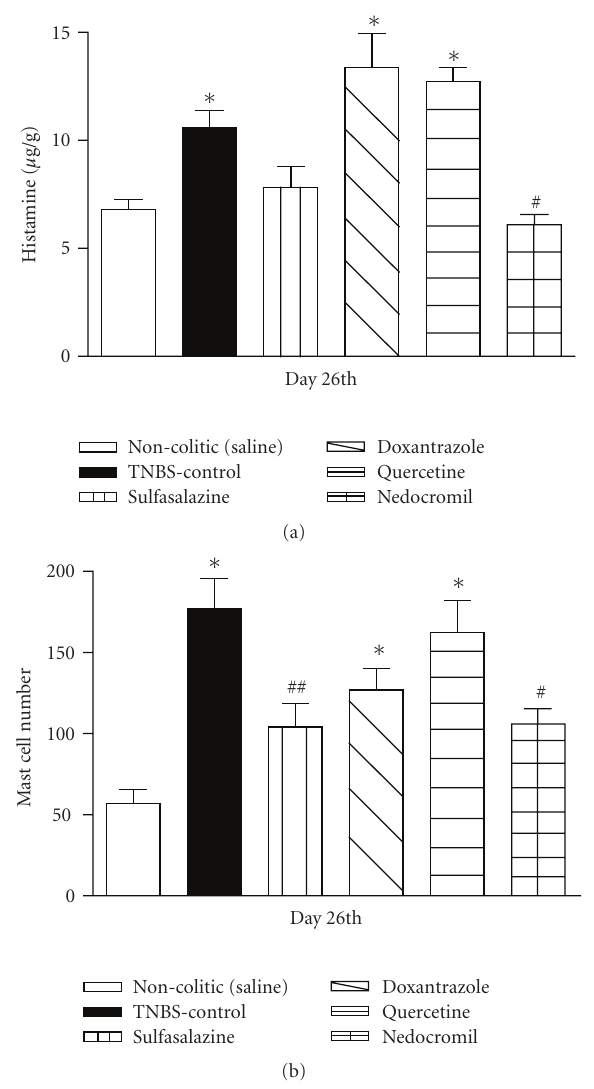
Figure 3: (a) Histamine concentration and (b) mast cell number in colon of Wistar rats with colitis induced by TNBS treated with sulfasalazine (25mg/Kg/day) doxatranzole (5mg/Kg/day), quercetine (10 mg/Kg/day), or nedocromil (100mg/Kg/day) daily from 14th until 26th days of induction of the colitis. The results are expressed as mean ± SEM ( n = 5–7). ∗ P < . 05 versus noncolitic group. # P < . 05; ## P < . 01 versus TNBS control group (by